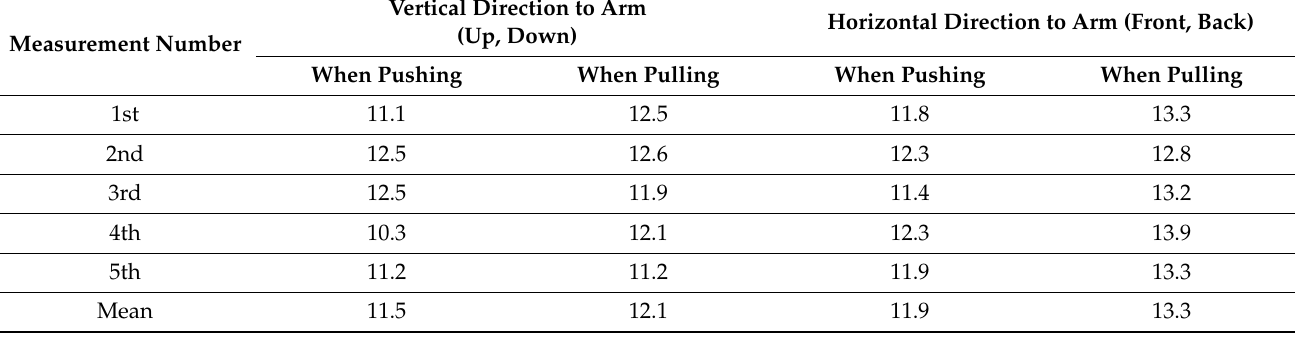
Table 1. Measurement of force that the HapTug can exert at the default position (unit: N). Measurement Number Measurement